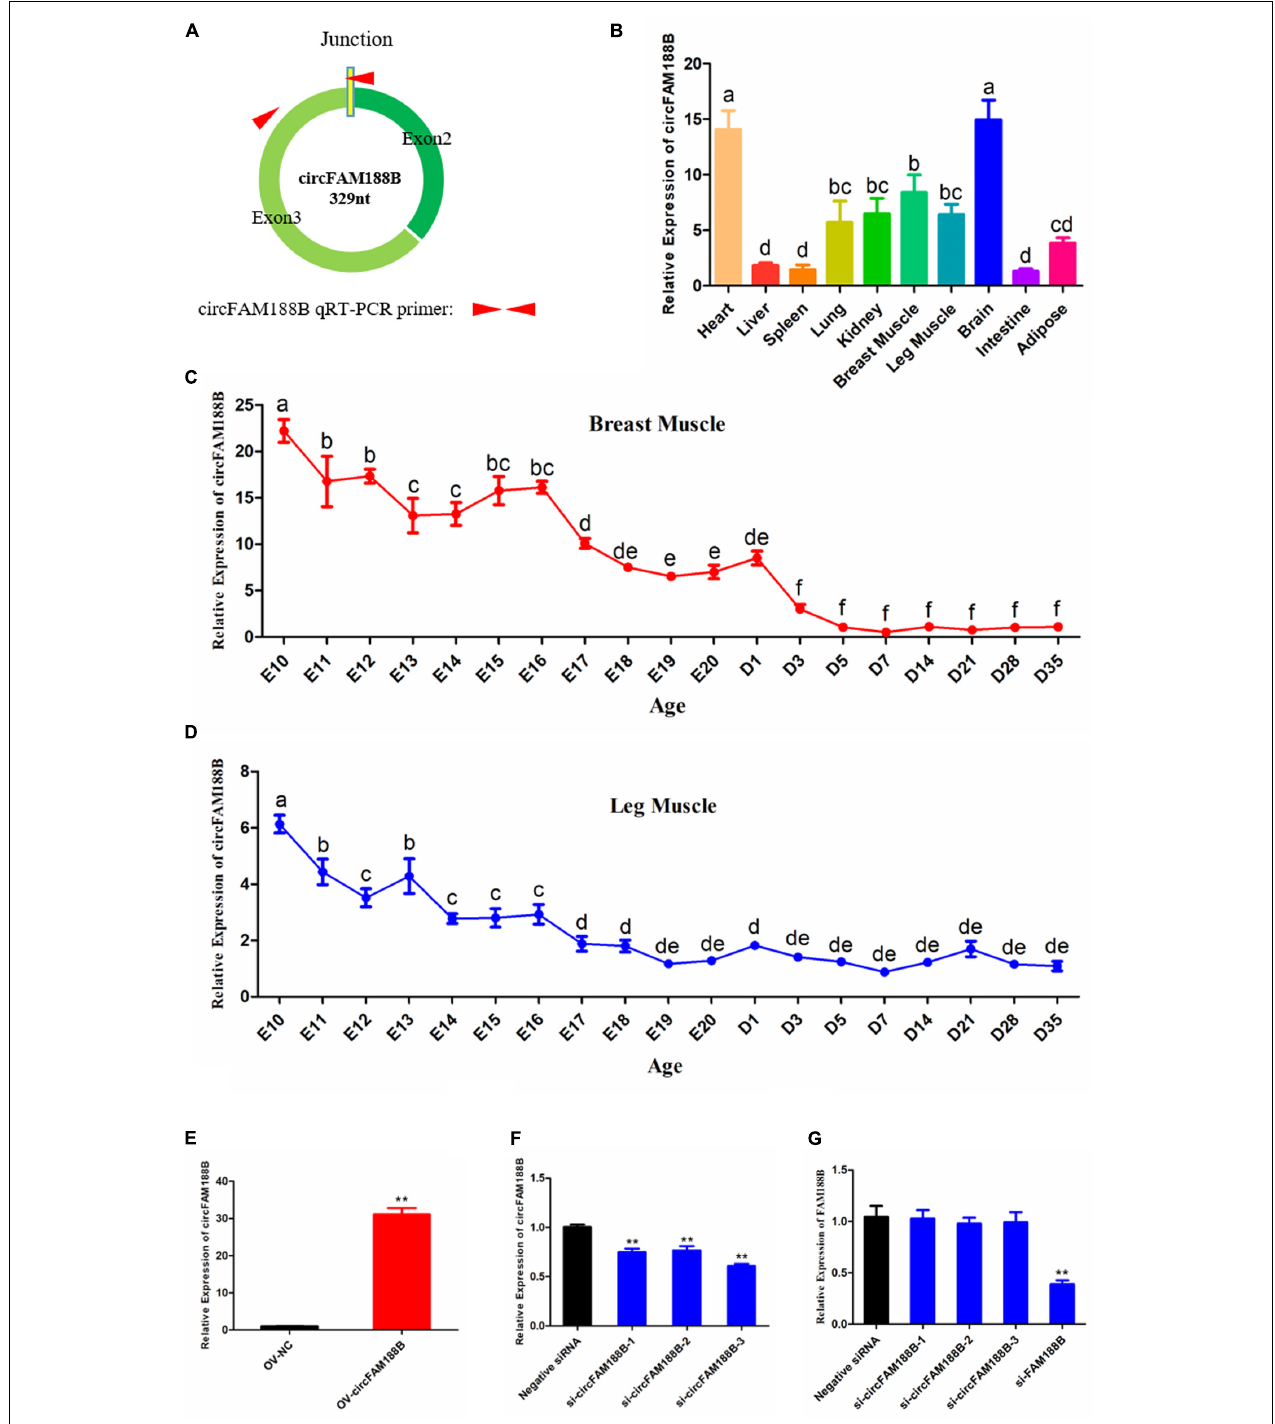
FIGURE 1 | CircFAM188B expression patterns in chicken. (A) Schematic diagram of circFAM188B formation and qRT-PCR primer design. (B) circFAM188B expression profiles in ROSS-308 chicken tissues. (C) The relative RNA level of circFAM188B in the breast muscles of E10-D35 chicken. (D) The relative RNA level of circFAM188B in the leg muscles of E10-D35 chicken. (E) The relative expression of circFAM188B in SMSCs transfected with OV-circFAM188B or OV-NC vector. (F) The relative expression of circFAM188B in SMSCs transfected with circFAM188B-specific siRNA or negative control siRNA. (G) The relative expression of FAM188B gene in SMSCs transfected with circFAM188B-specific siRNAs, FAM188B-specific siRNA or negative control siRNA. The results of all groups are shown as mean ± S.E.M., and the data represent three independent assessment methods. The one-way ANOVA (B–D) and Student’s t -test (E–G) were used to compare expression levels among different groups. Different letters means indicate statistical significance. * P < 0.05; ** P < 0.01; a , b P < 0.05.